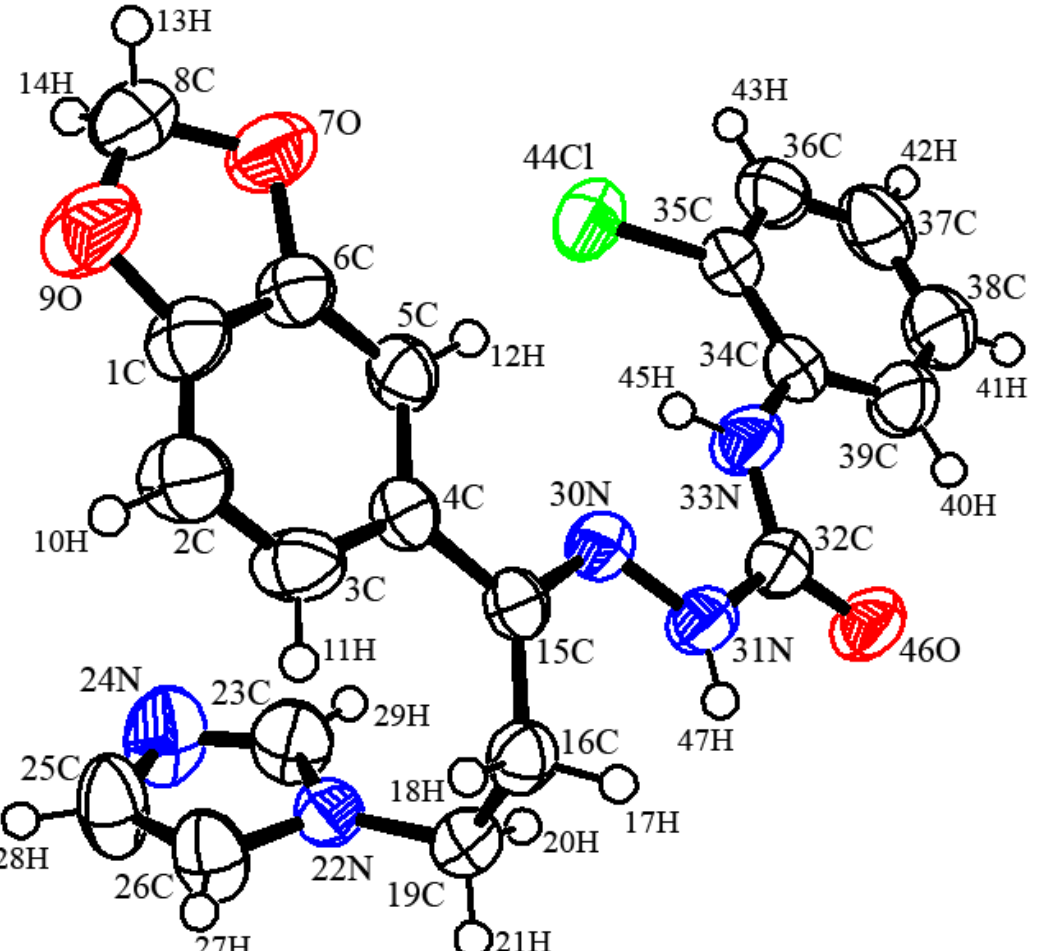
Figure 1. Oak ridge thermal ellipsoid plot diagram of the semicarbazones 4 drawn at 50% ellipsoids for non-hydrogen atoms.